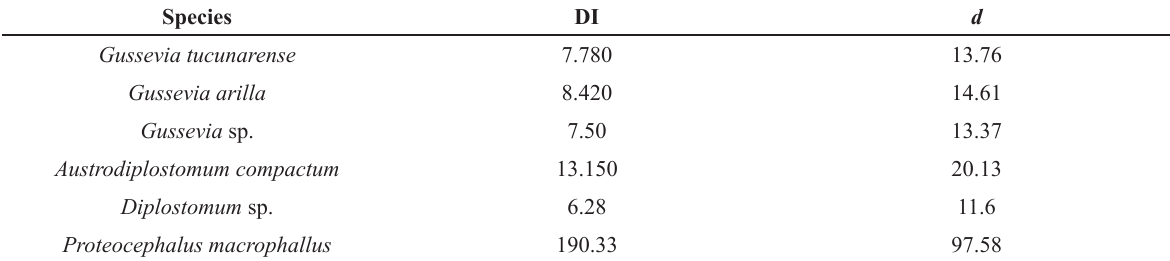
Dispersion index (DI) and statistical testing of each parasite species found in Cichla ocellaris Bloch & Schneider, 1801 collected in Jacaré-Pepira River, State of São Paulo,